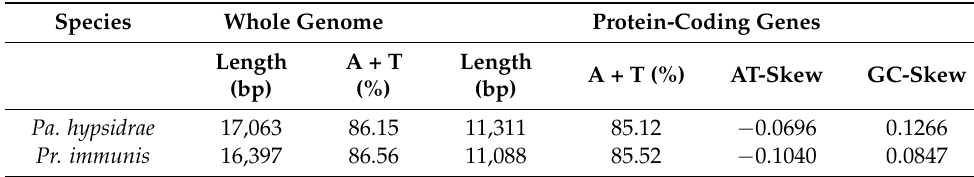
Table 1. Base composition of Pa. hypsidrae and Pr.